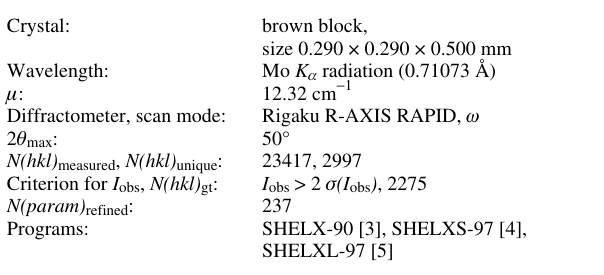
Table 1. Data collection and handling.